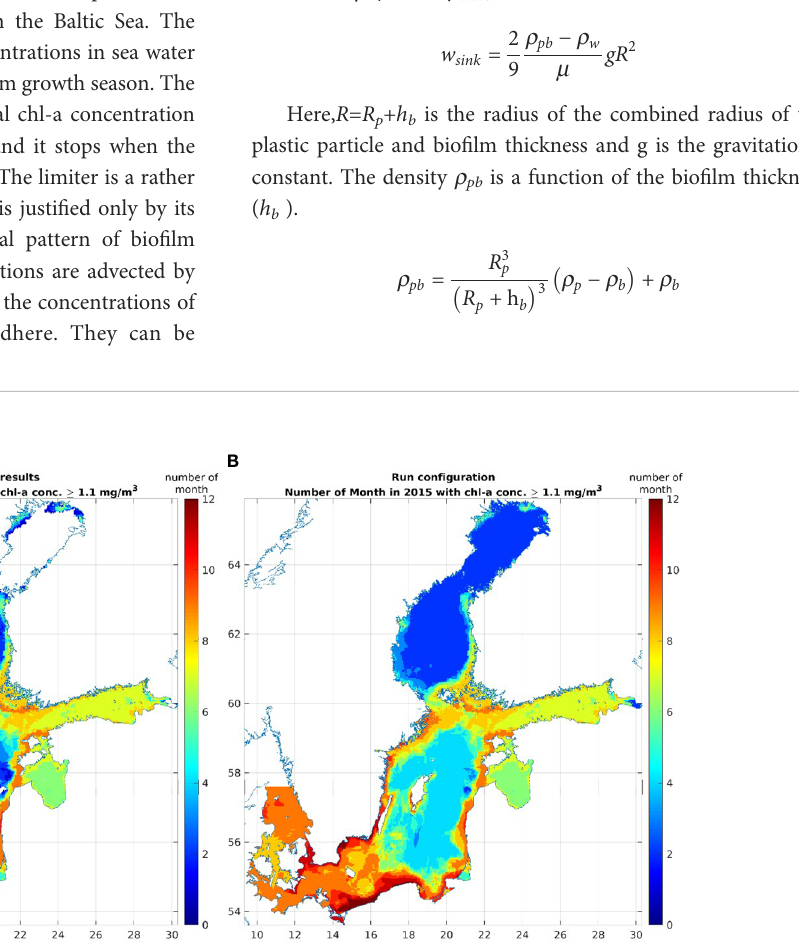
FIGURE 2 Seasonal pattern of bio fi lm growth: CMEMS bio-reanalysis (BalMFC, 2019) product (A) and combined reanalysis and satellite data (OC-TAC, 2019) product (B) , with extended growth season: May – August in the entire Baltic